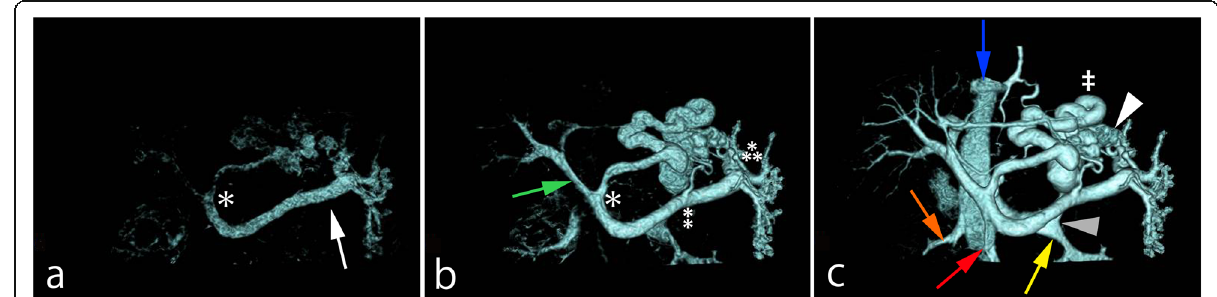
Fig 1 A 67-year-old female with gastric varices and hepatic encephalopathy. Volume rendering images, anterior aspect. a Early image depicts the splenic vein (white arrow) and left gastric vein (asterisk). b Mid-phase image additionally depicts the portal vein (green arrow), retro gastric vein (double asterisk), and short gastric vein (triple asterisk). c Late image depicts gastric varices (white arrowhead) and gastrorenal shunt (gray arrowhead) behind the splenic vein. The red, blue, yellow, and orange arrows indicate the superior mesenteric vein, inferior vena cava, left renal vein, and right renal vein, respectively. The portosystemic shunt (double dagger) is composed of afferent veins (left gastric, retro gastric, and short gastric veins) and an efferent vein (gastrorenal shunt)